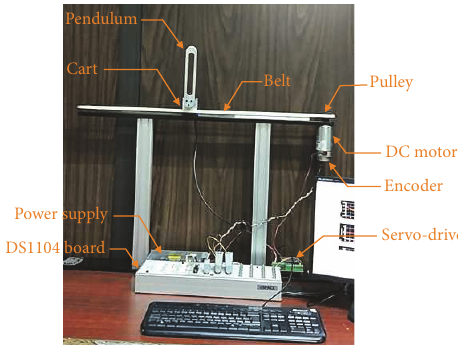
Figure 2: Prototype of the inverted pendulum on a